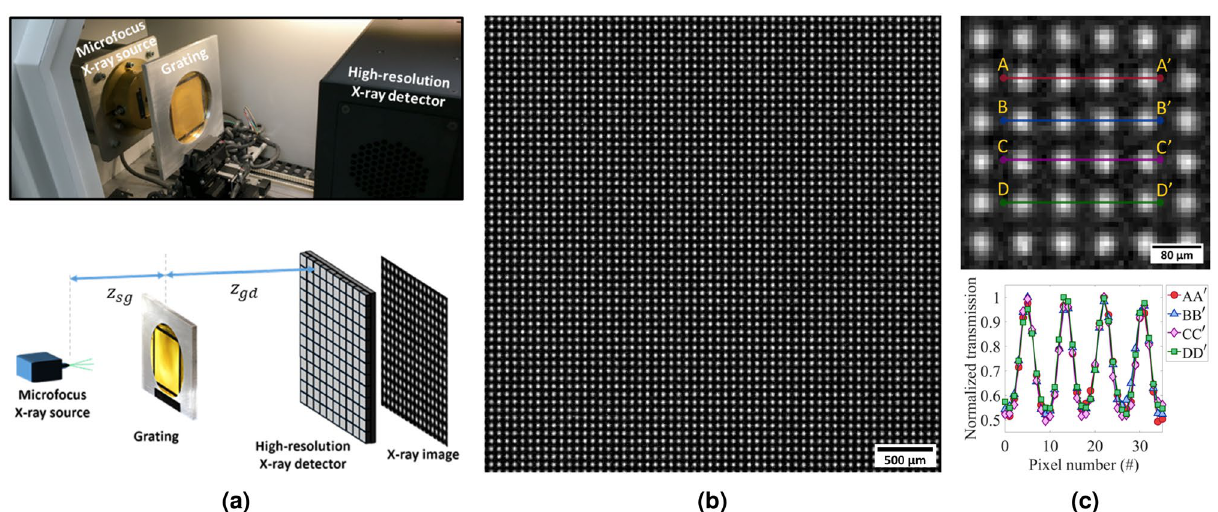
Figure 9. ( a ) Demonstration of the 3D X-ray Microscope—inCiTe™—and the test setup we used for taking X-ray projection of the prototype version of our grating. ( b ) X-ray projection of the SU-8 micropillar-based X-ray grating with three layers at 60kV p ; a magnification of 4.5 was used in this X-ray projection. ( c ) A closer view of grids in the X-ray projection image (top), and the cross-sectional profiles of normalized transmission of grids across four rows of grids